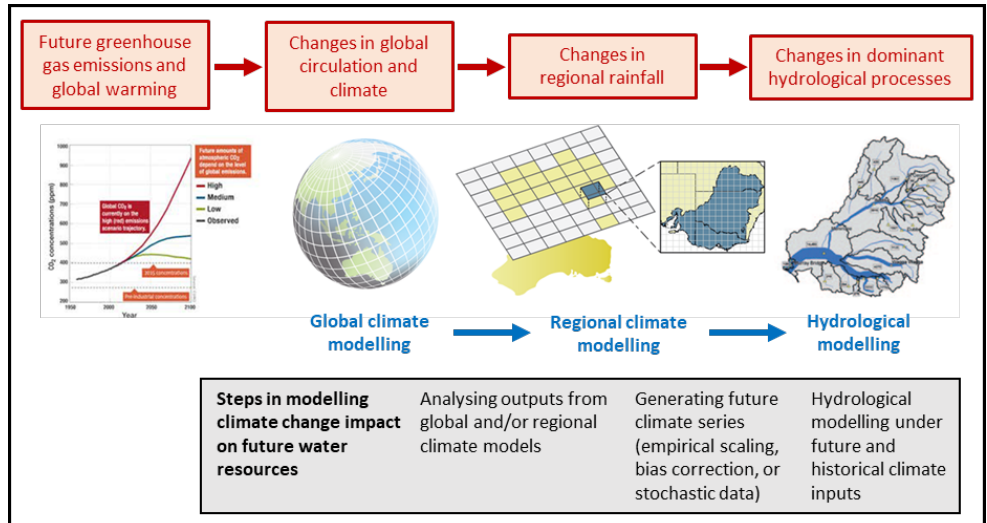
Figure 1. Components in the modelling climate change impact on streamflow.